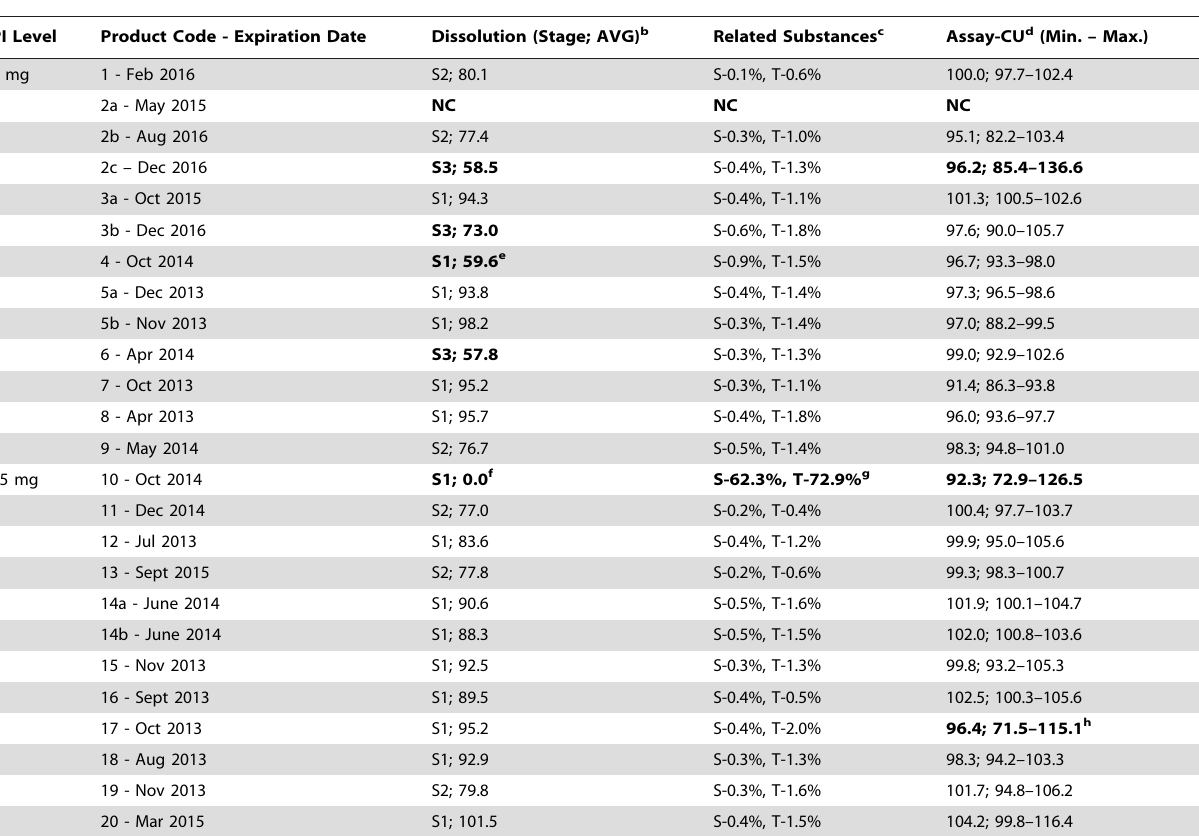
Table 1. Summary of results for the ECP quality survey a